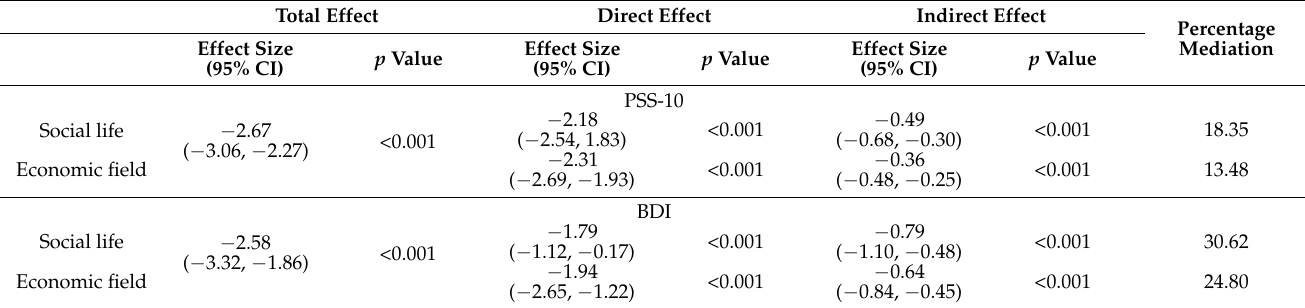
Table 5. Mediation